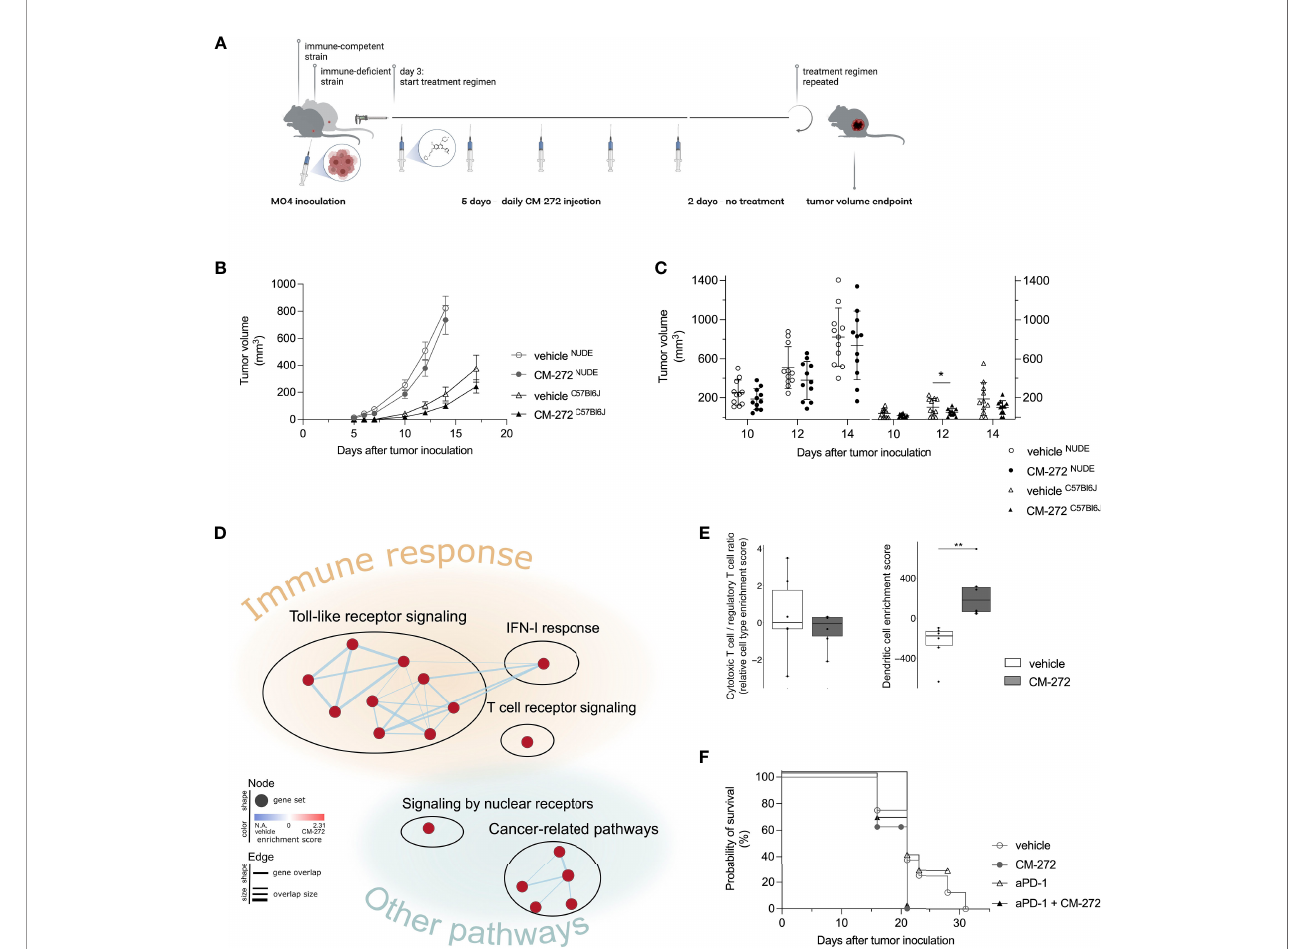
FIGURE 4 | Dual G9a and DNMT inhibition transiently delays MO4 tumor growth in immune-competent mice. (A, C) CM-272 therapy in immune-de fi cient (NUDE) and -competent (C57Bl6J) MO4-bearing mice. (A) Schematic representation of treatment regimen ( n =1, 11 m.p.c.). (B, C) Tumor volume in time (mean ± SEM [B]/ mean ± SD [C]). (D, E) Multiplex tumor analysis (706.9 ± 193.8 mm 3 ; n =1, 12 m.p.c.). (D) Graphical representation of GSEA. (E) TIL-scoring (10-90 percentile Box&Whiskers). (F) Mice survival (Kaplan-Meier curve) upon CM-272 combination with PD-1 blockade (aPD-1; n =1, 6-8 m.p.c.). Vehicle and CM-272 conditions were compared using REML modeling and post-hoc Sidak multiple comparison test (B) ; unpaired one-tailed student t -test with Welsh correction or Mann-Whitney test (C) ; Wilcoxon rank sum test (E) ; Log-rank test (F) . Asterisks indicate statistical signi fi cance: *p ≤ 0.05; **p ≤